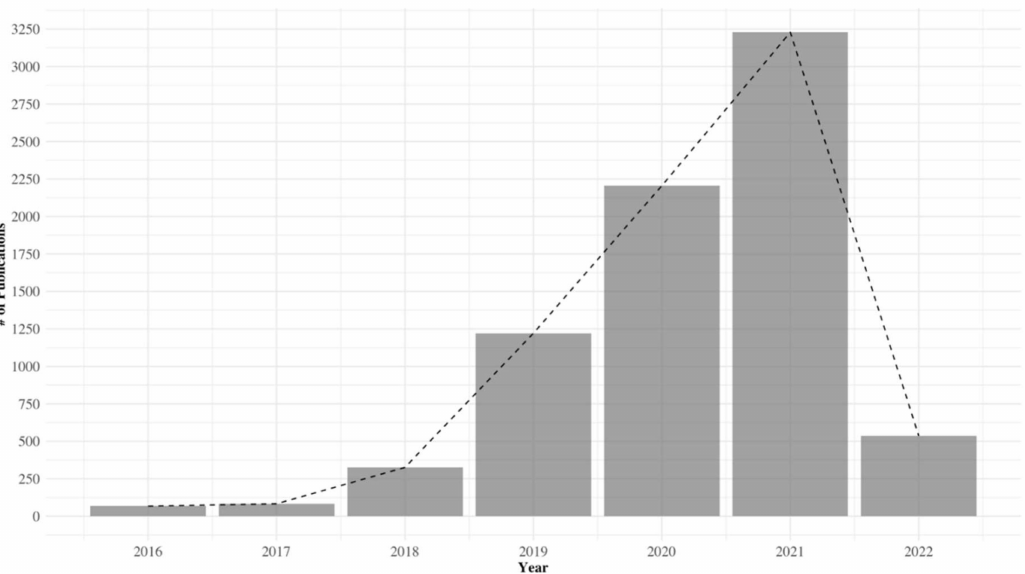
Figure 1. Journal publication trends based on number of publications by year. The sample data were collected in the first quarter of